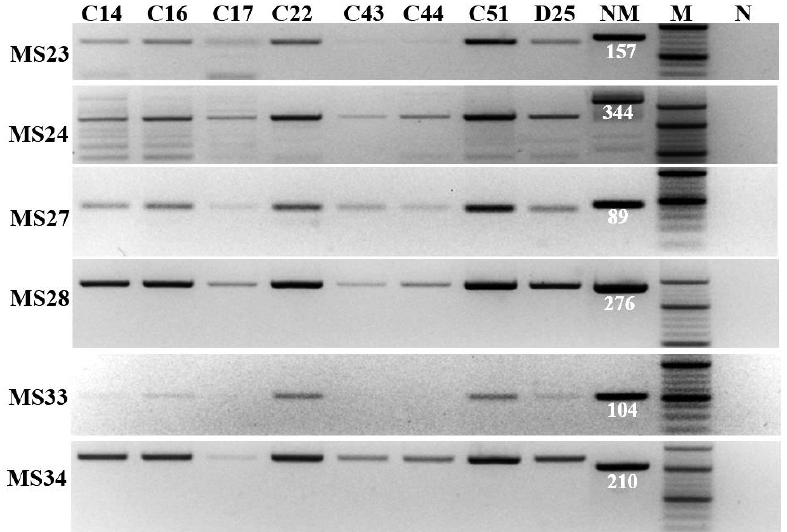
Figure 1. MLVA typing of C. burnetii . PCR products of six markers (MS23, MS24, MS27, MS28, MS33, and MS34) were amplified from eight vaginal swab samples: C14, C16, C17, C22, C43, C44, C51, and D25. The reference Nine Mile strain (NM) with amplicon size (in base pair long) of each marker is indicated, “M” is 20 bp DNA marker, and “N” is negative control without DNA template.